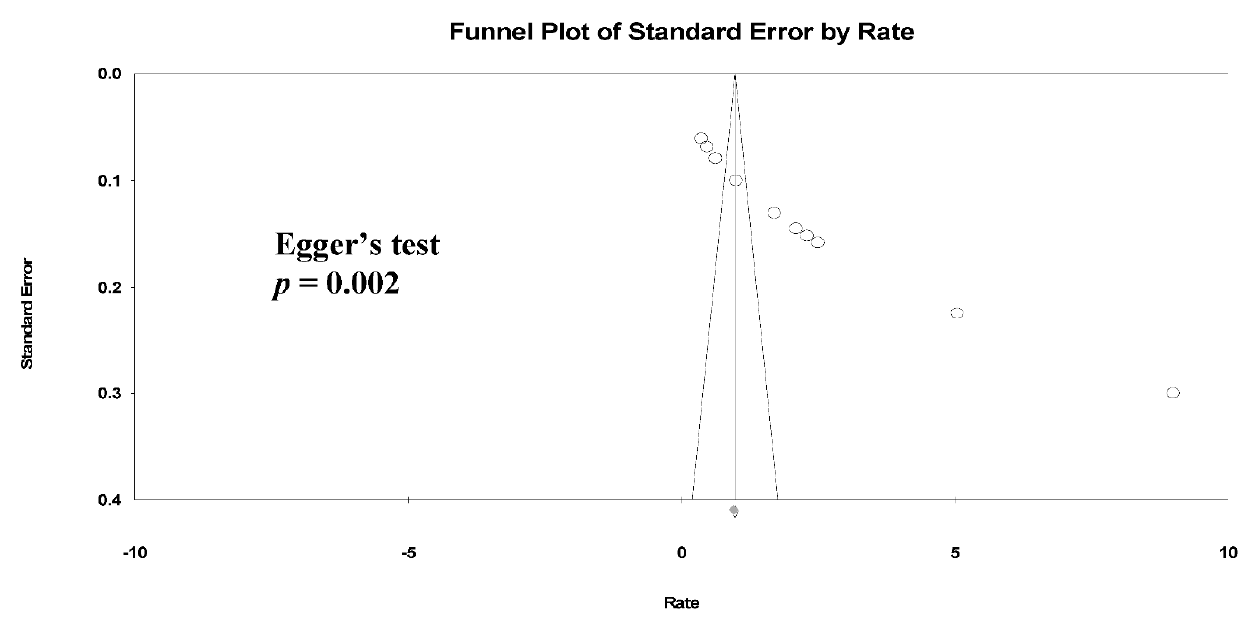
Figure 3. Funnel plots of HZ incidence. (Note: in the graph, the observed studies are shown as open circles and the observed point estimate in log units us shown as a diamond).